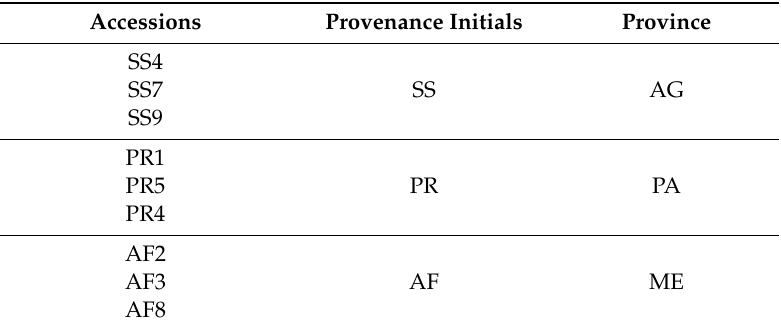
Table 1. List of accessions in the test.